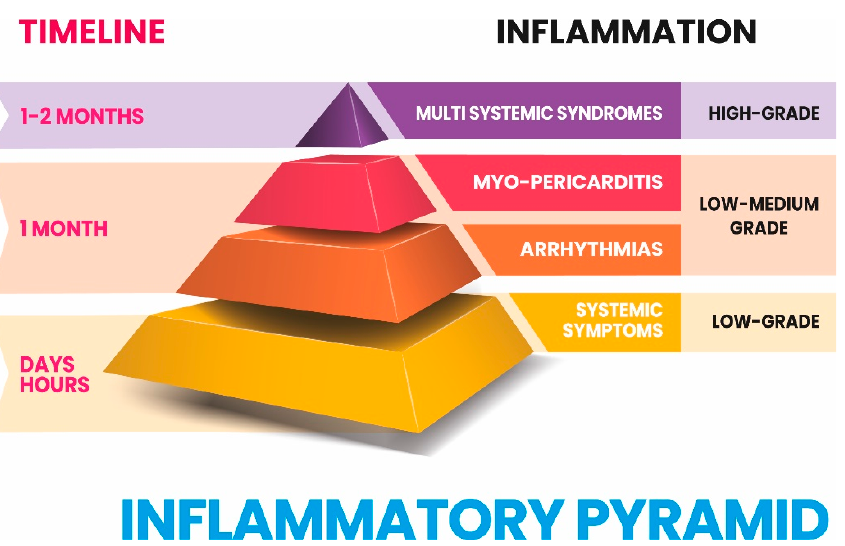
Figure 1. Inflammatory Pyramid (IP) following COVID-19 mRNA vaccines. In our hypothesis, we correlated the timeline of COVID-19 mRNA vaccine adverse events to the degree of inflammation that can occur after their injection. On the left side, we have diversified the time of onset of adverse events, based on the scientific literature presented here. On the right side, we stratified the degree of inflammation into three progressive levels starting from the base of the IP to reach its apex: low-grade, low-medium grade, and high grade of inflammation. The levels of the pyramid are occupied by adverse events, which start from the base and lead to the apex with this increasing degree of clinical complexity: systemic symptoms, heart disease, hyperinflammatory multisystem syndromes (MIS). The timeline correlates with the degree of inflammation and both relate to the different severity of the clinical manifestations temporally associated with the first injection of COVID-19 mRNA vaccines.